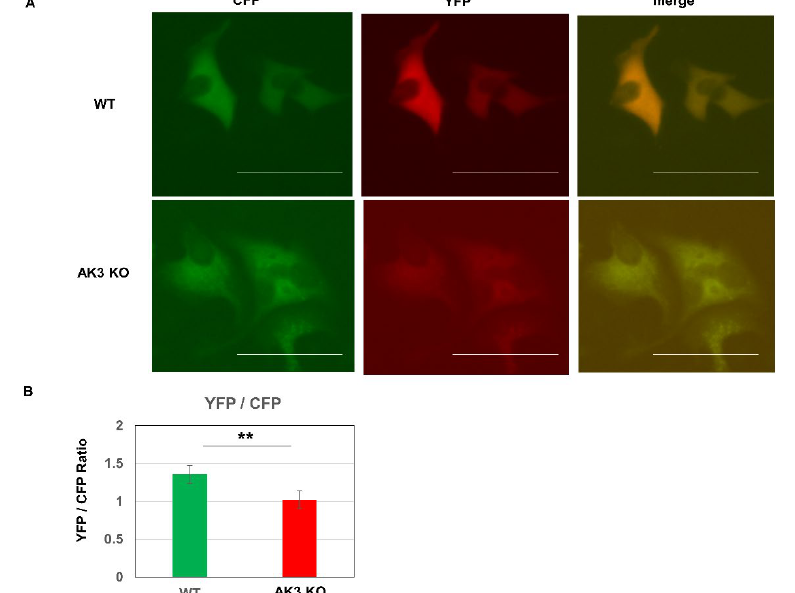
Figure 5. Analysis of proliferation and energy metabolism of adenylate kinase 3 knockout (AK3KO) cells. ( A ) Evaluation of intracellular ATP: Ateam plasmid was introduced to evaluate intracellular ATP levels and its expression was analyzed. Fluorescence of cyan fluorescence protein (CFP, 475 nm) and yellow fluorescence protein (YFP (527 nm) were evaluated for ATP non-binding and ATP-binding, respectively. ( B ) Comparison of YFP/CFP expression. ** p < 0.01.